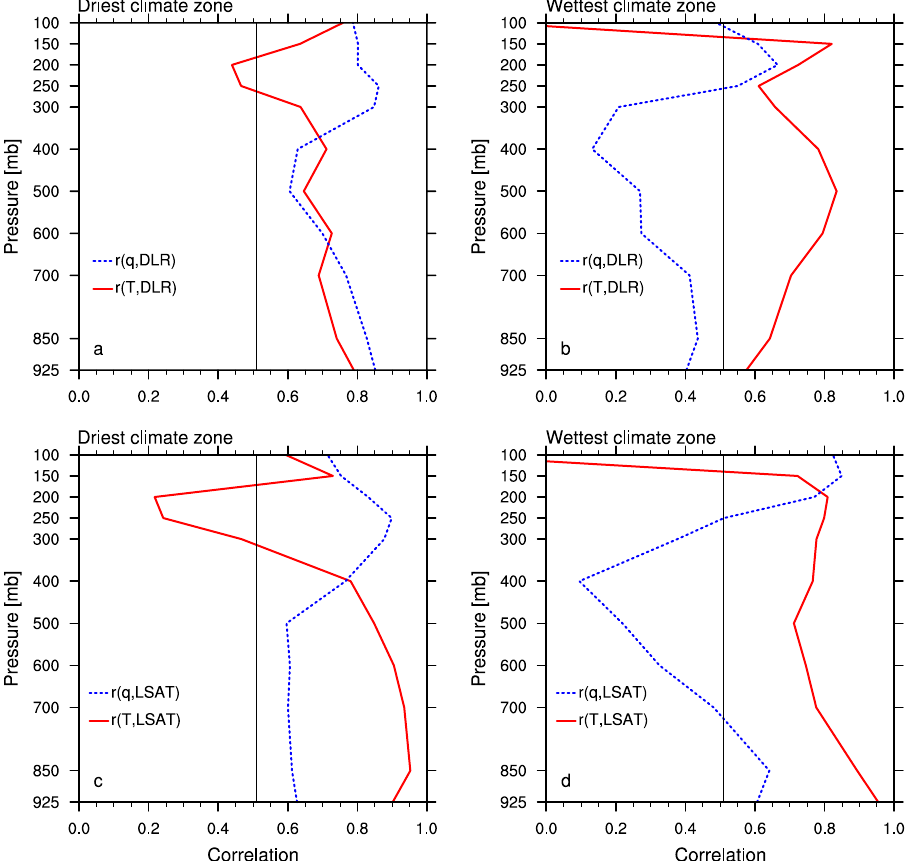
Figure 8. Correlations between atmospheric annual T and q anomalies with the annual anomalies of ( a , b ) DLR and ( c , d ) LSAT as a function of pressure (mb) for the period 2003–2015 averaged over the ( a , c ) driest and ( b , d ) wettest from the 12 large-scale climate zones classified by precipitation. Correlation coefficients greater than 0.51 (the black vertical line) are statistically significant (p <